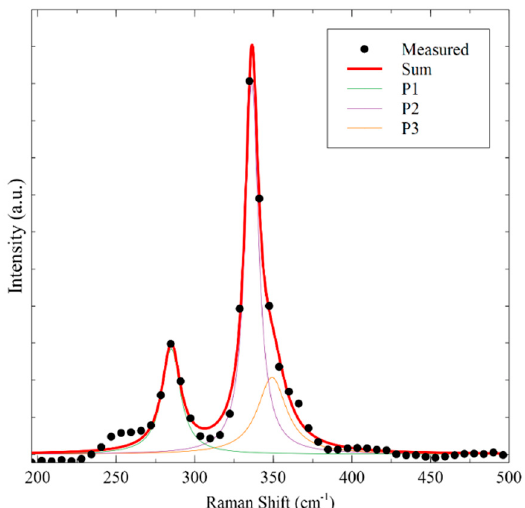
Figure 2. Raman spectrum for CZTS thin film, fitted using Lorentzian curves. Peaks were determined to be at 285 cm − 1 (P1), 336 cm − 1 (P2), and 349 cm − 1 (P3).